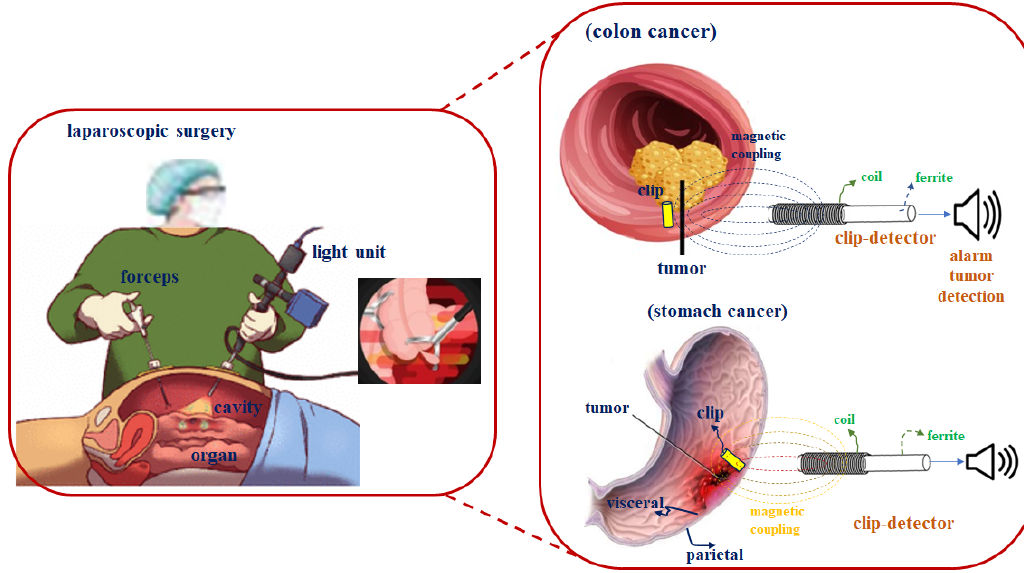
Figure 3. Coupling between clip and